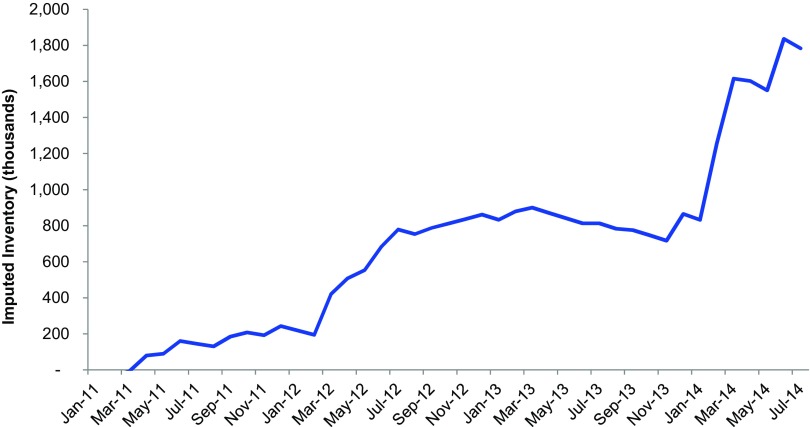
Imputed Inventory, Ethiopia Model as an Example